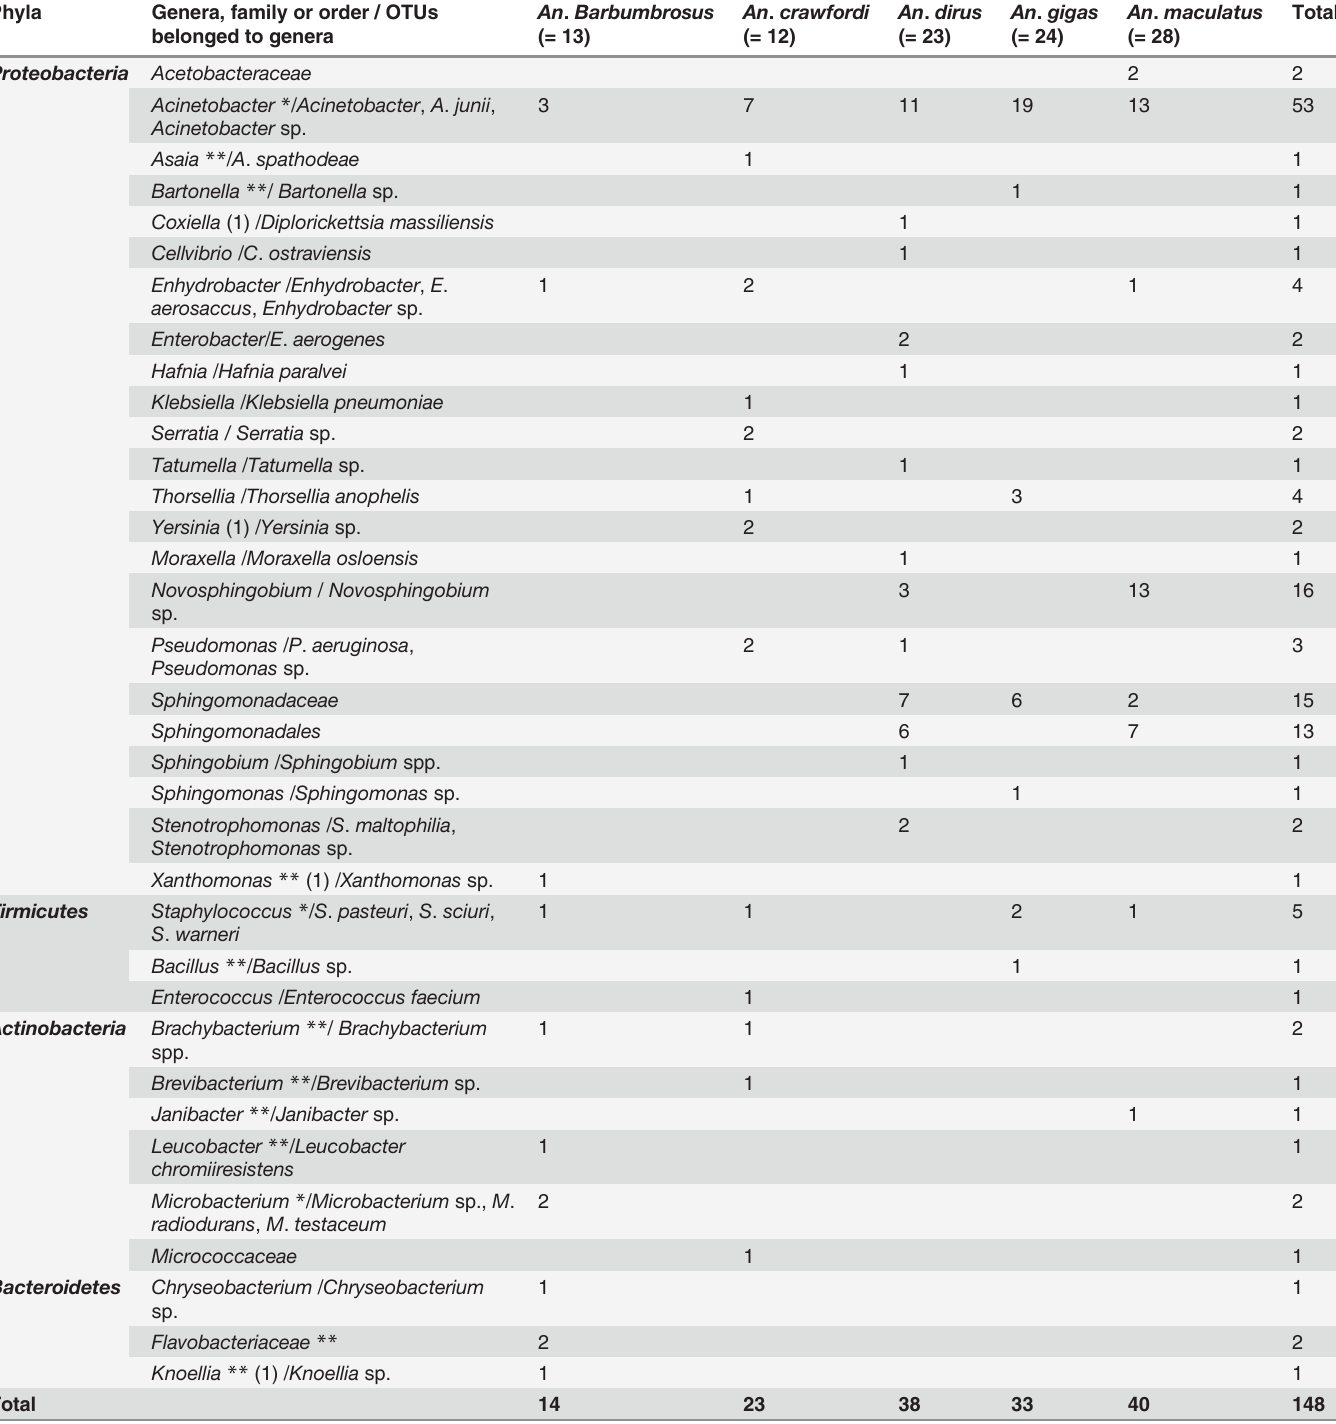
Table 1. Bacterial genera and OTUs in abdomens of Anopheles species collected in Vietnam. Phyla Genera, family or order / OTUs belonged to